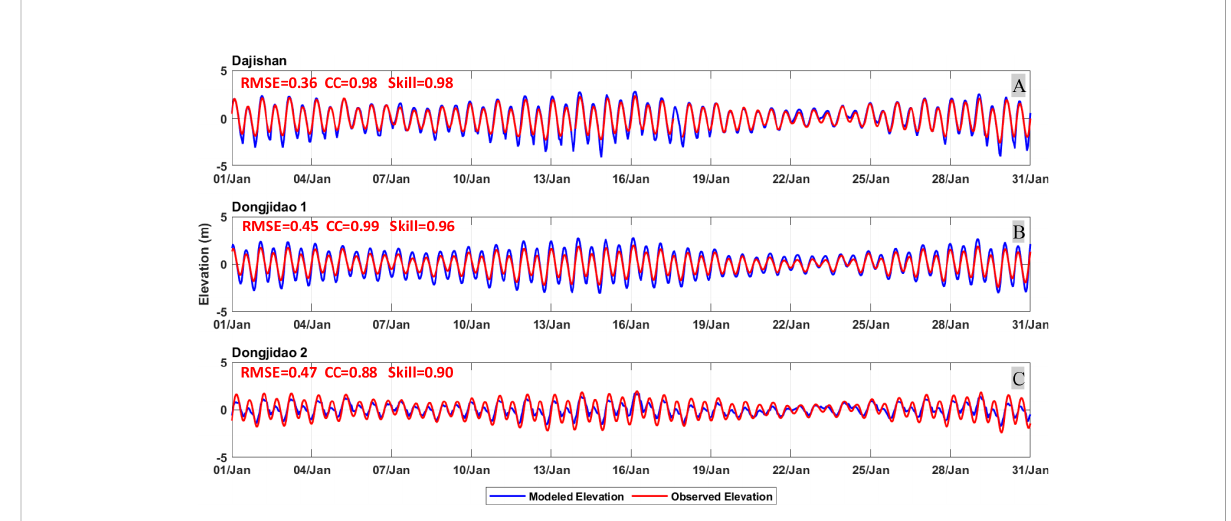
FIGURE 4 Comparison of modeled and observed elevations at three sea fl oor observation systems. Each station ’ s statistical parameters (RMSE, CC and